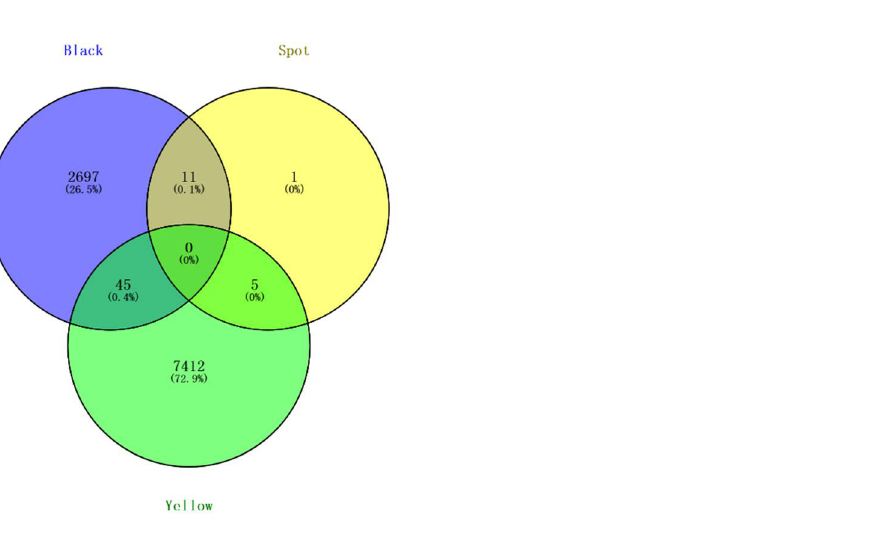
Figure 4. Venn analysis of all beak colors showing overlap of significant SNPs.